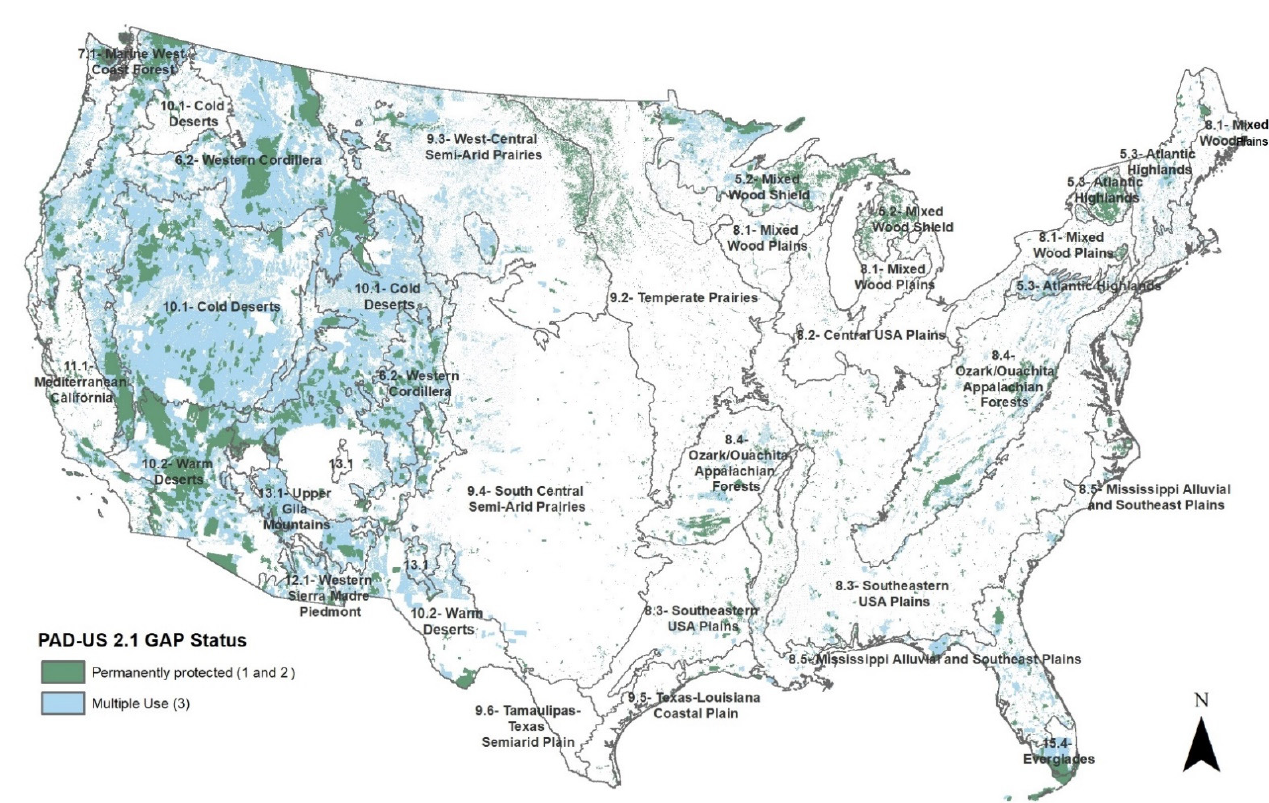
Figure 2. Map of the distribution of Protected Areas of the U.S. (PAD-US 2.01[46]) and Level II Ecoregions [55].